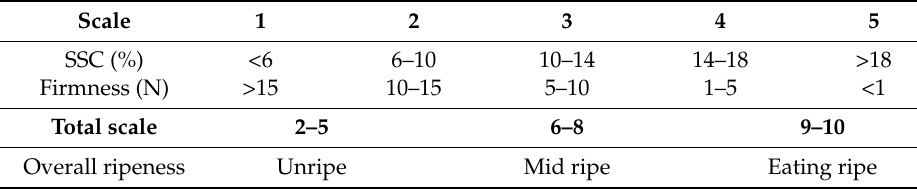
Table 2. The evaluation criteria for overall